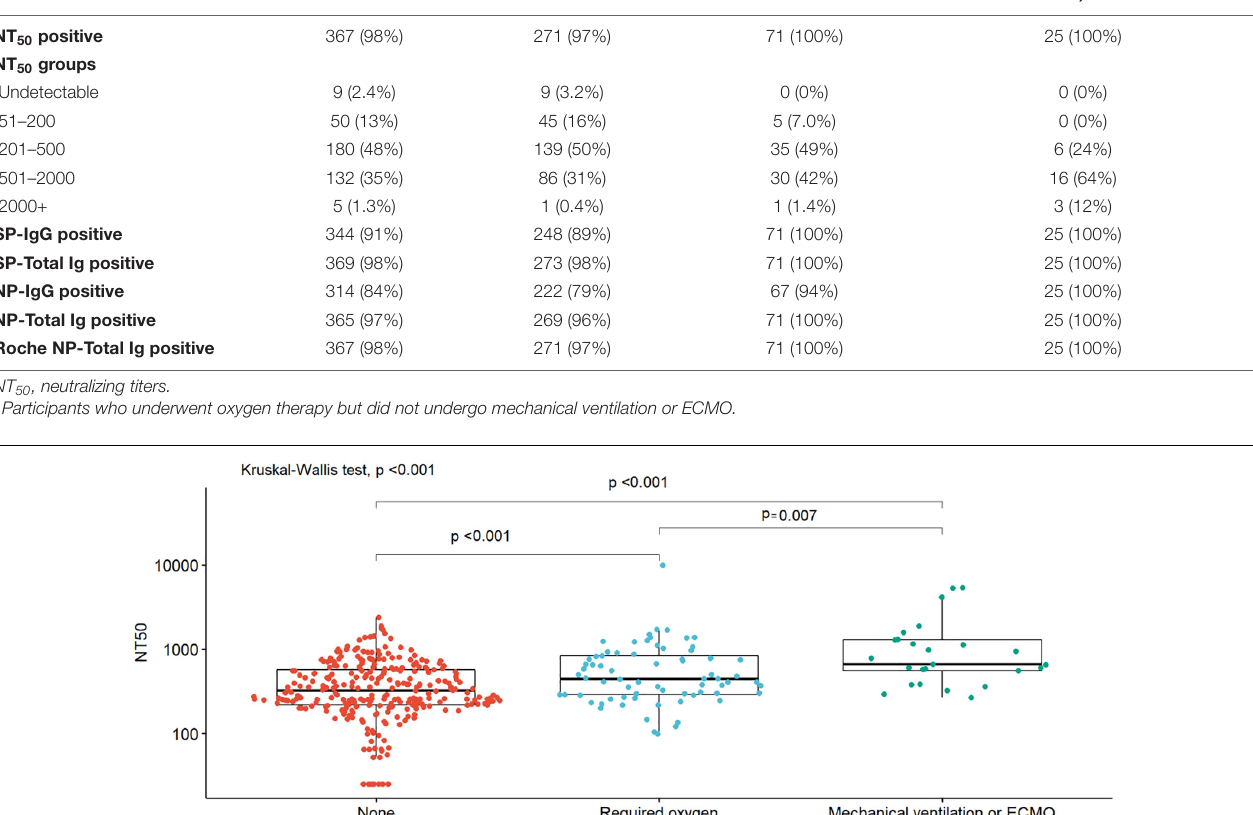
against NP antigen showed weak correlations with NT 50 ( r =